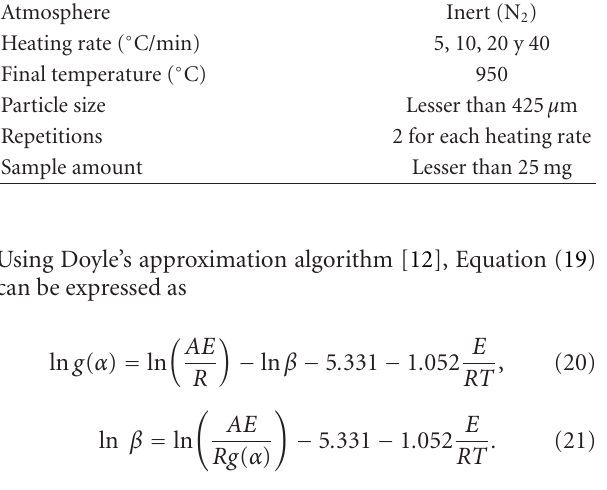
Figure 1: E ff ect of the ER on the Production of H 2 , CH 4 , CO, and CO 2 for S:F = 0, S:F = 0.5, and T = 873K, estimated by Atom balance